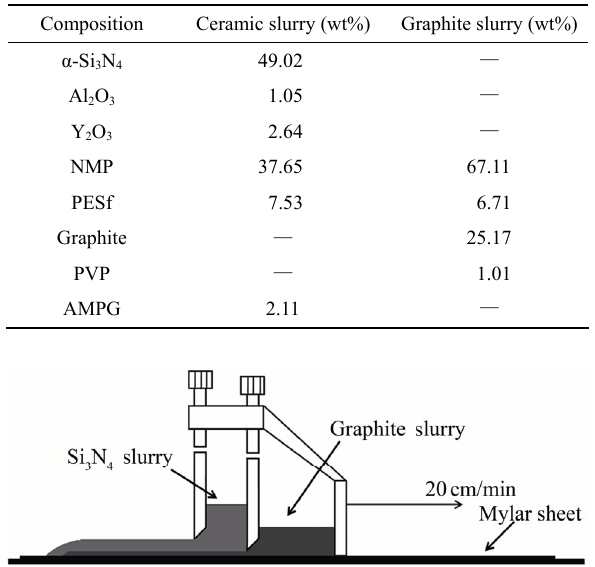
Fig. 1 Schematic illustration of the doctor blade system for phase inversion tape